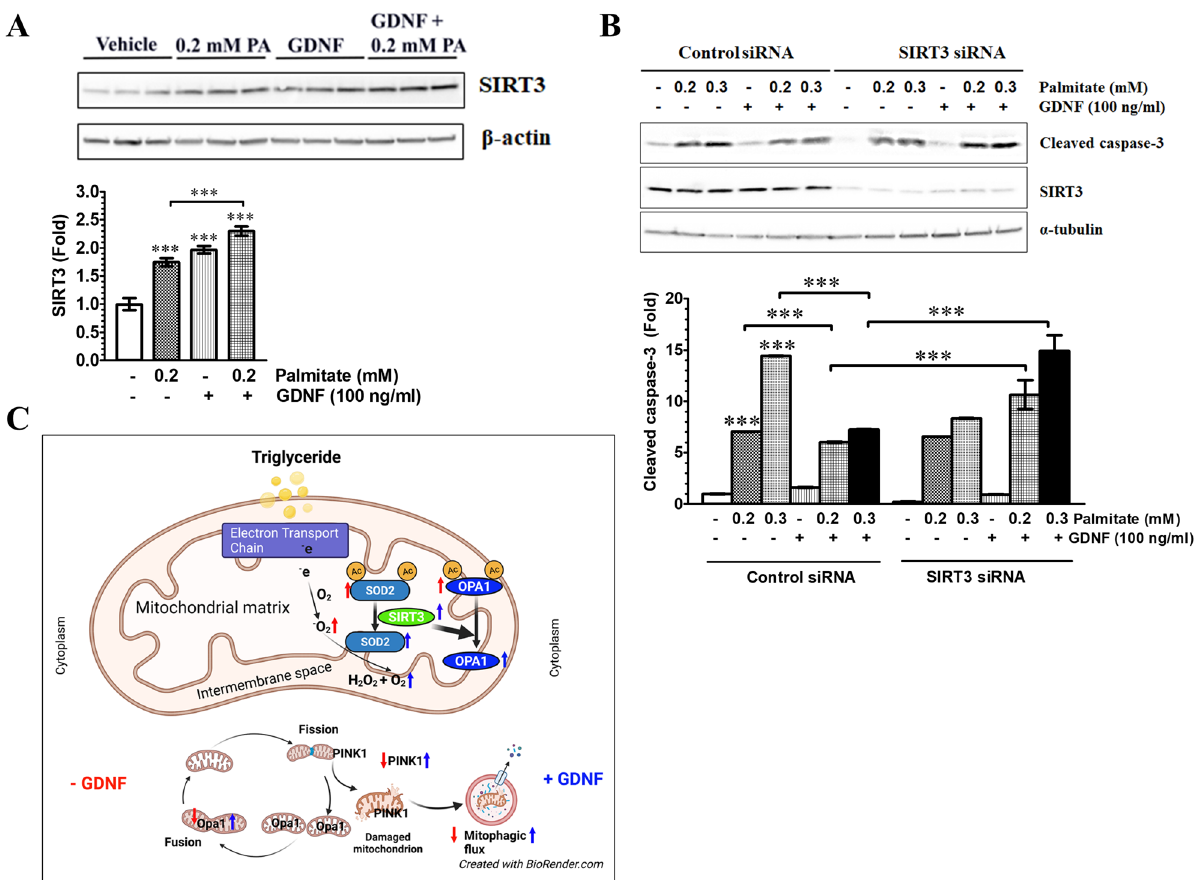
Figure 4. Knocked down of SIRT3 expression abolishes GDNF protection against palmitate-induced hepatocyte cell death. ( A ) Western blot analysis of SIRT3 and β-actin (loading control) protein levels in rat hepatocytes exposed to PA and GDNF for 24 h. The bands were cropped from the original blots presented in Supplementary Fig. S7. Plotted are means ± SE. ***P < 0.001, relative to Vehicle; N = 4. ( B ) Western blot analysis of SIRT3, cleaved caspase-3 and α-tubulin (loading control) levels in control siRNA and SIRT3 siRNA- transfected rat hepatocytes after 24 h exposure to palmitate (PA) and GDNF. The bands were cropped from the original blots presented in Supplementary Fig. S8. Plotted are means + SE. ***P < 0.001, relative to Vehicle- treated hepatocytes; N = 3. ( C ) Summary of proposed mechanism of GDNF action to protect hepatocytes against oxidative stress resulting from increased β-oxidation involving enhancement of superoxide dismutase (SOD) activity and SIRT3 levels as well as enhancement of resistance against fatty acid-induced suppression of mitophagy. To counter the increased mitochondrial generation of reactive oxygen species (ROS) GDNF increase SIRT3 levels and deacetylase activity which results in enhanced activity of mitochondrial SOD enzymes and their catalysis of the breakdown of ROS. GDNF also enhances mitochondrial cycling and removal of excess and damaged mitochondria through